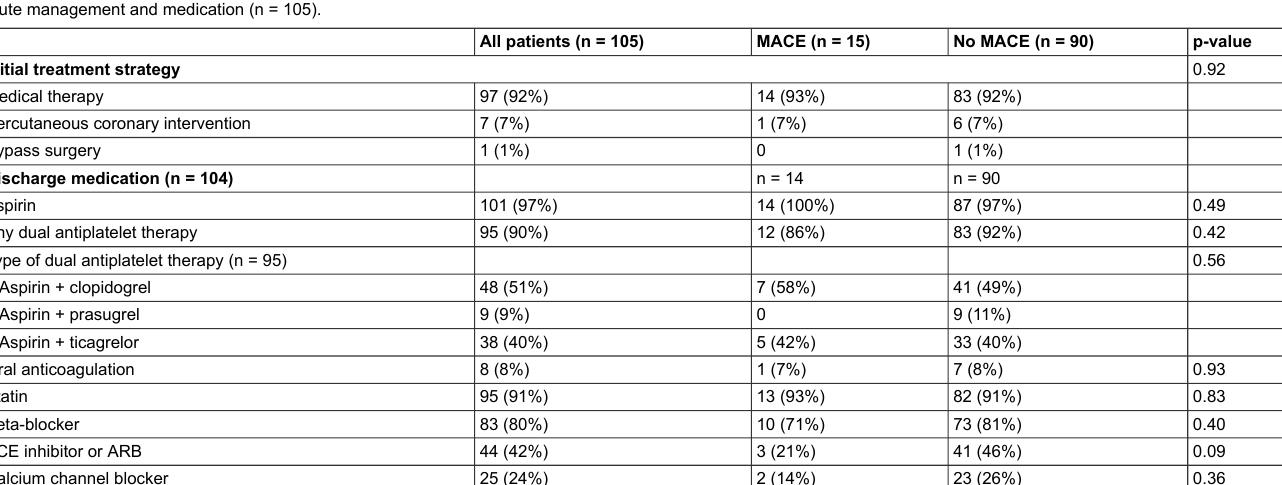
Table 3: Acute management and medication (n = 105).